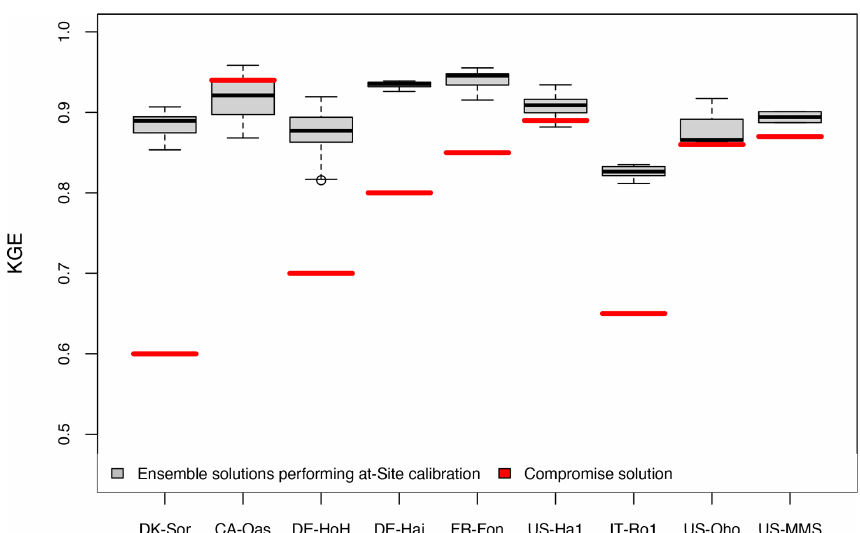
Figure 8. Comparison between KGE obtained from ensemble-simulated GPP performing at-site calibration, and the KGE obtained from compromised